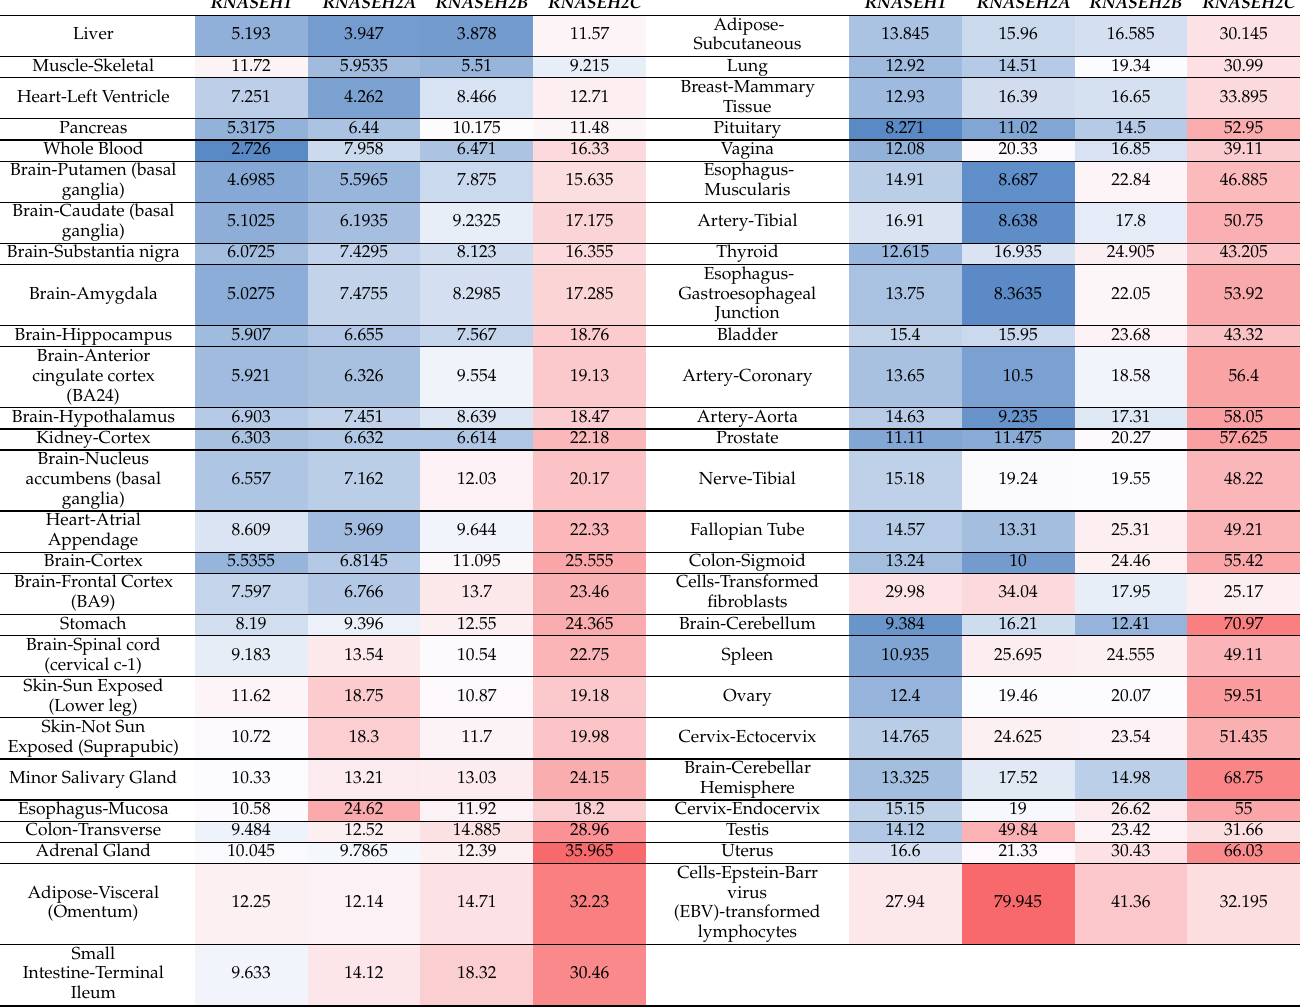
Table 2. RNASEH2A is highly expressed in human proliferative tissue. Expression of RNASEH genes in different 53 human tissues. Data obtained from the Genotype-Tissue Expression portal (GTEx) consist of the median transcripts per million (TPM) from >90 individuals for each tissue. Blue color indicates low expression levels and red color indicates high expression